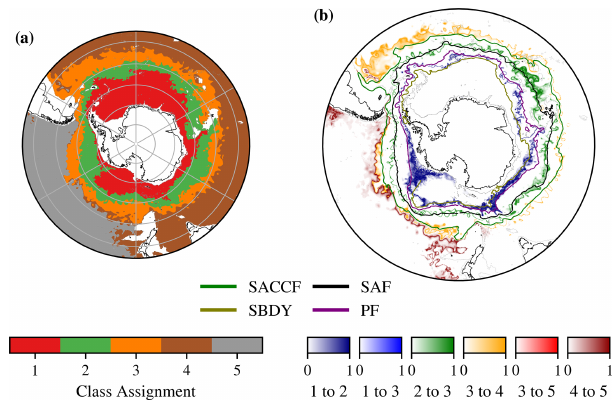
Figure 4. (a) The cluster assignments with K = 5 and (b) the I - metric for all present class transitions. This view highlights the tran- sitions between specific classes. The transitions in panel (b) have some similarities to the altimetric fronts from Kim and Orsi (2014). These fronts are shown overlain on panel (b) : SBDY – southern boundary; SACCF – southern ACC Front; PF – Polar Front; SAF – Subantarctic Front. Data are from June 2011 as a representative month.